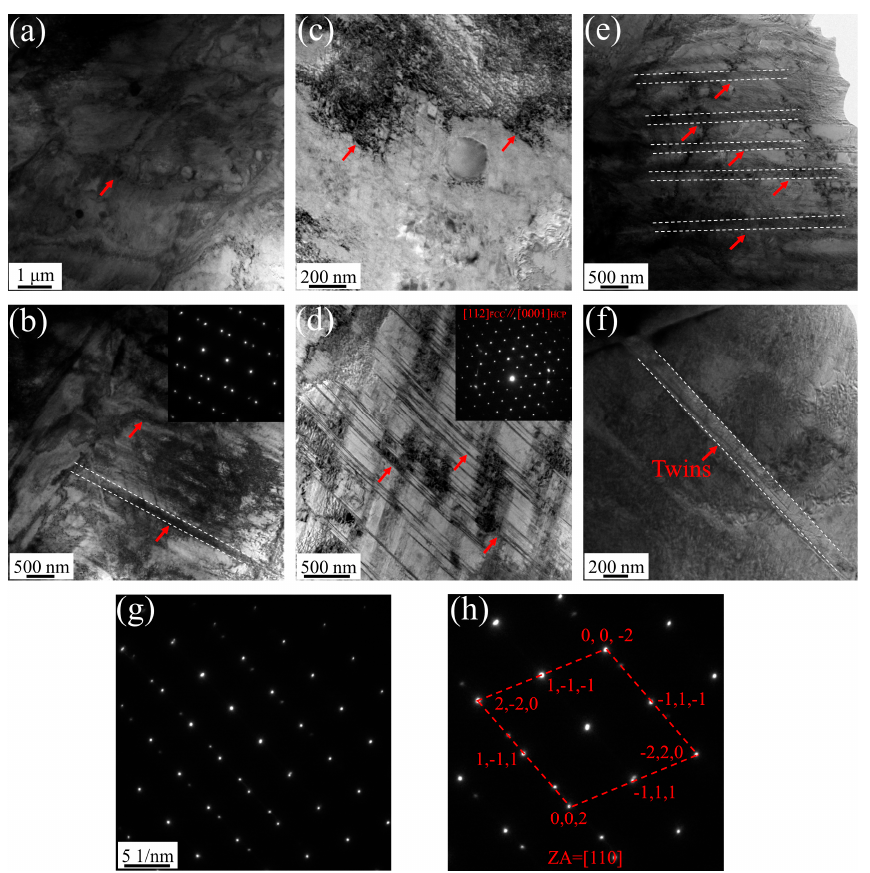
Figure 12. TEM images of Co40NiCrMo strips, Raw strips ( a , b ); cold-formed STACER ( c , d ); winding and stabilization STACER (520 ◦ C + 4 h) ( e – g ) selected-area electron diffraction (SAED) pattern for twins in ( f ); ( h ) indices to ( g ).